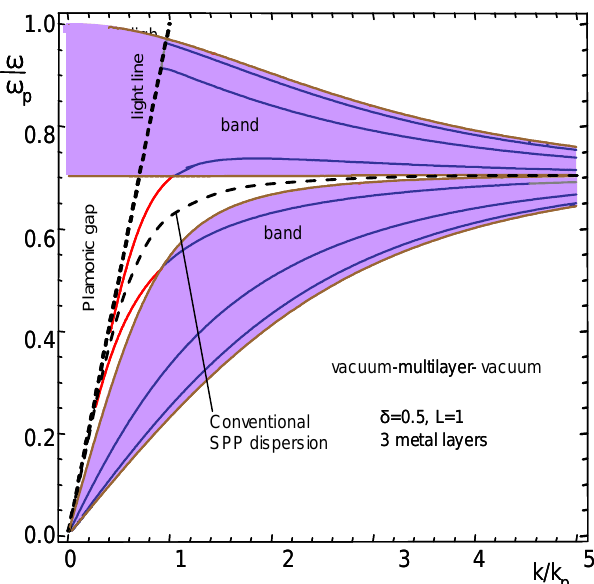
Figure 3. Dispersion of guided modes for N = 3, vacuum on both sides of the nanomembrane multilayer (exact